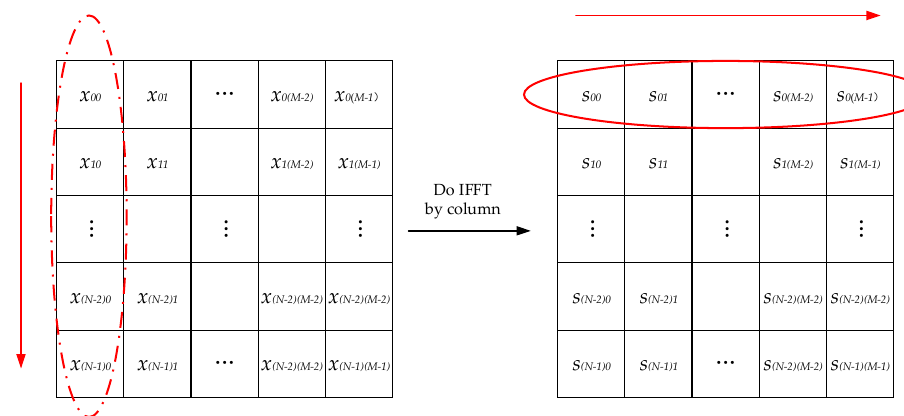
Figure 2. The grouping and inverse fast Fourier transform (IFFT) modulation.